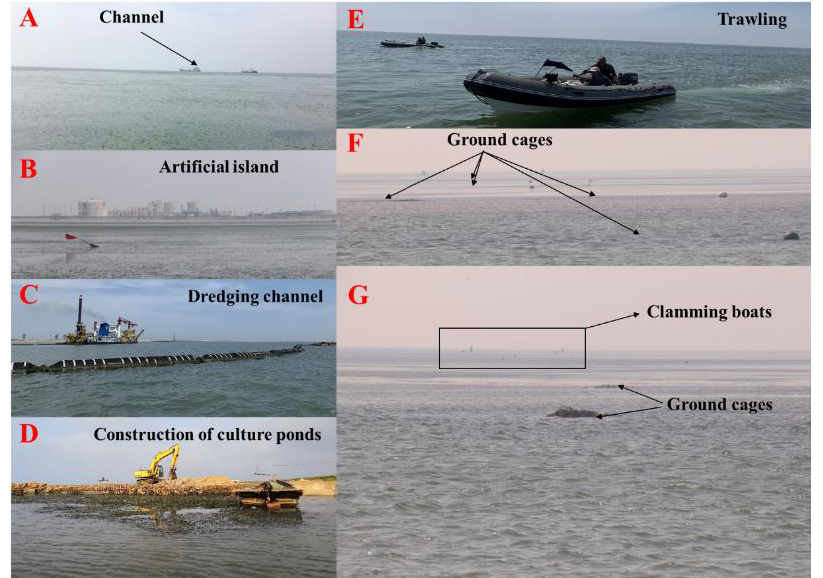
Figure 12. Existing seagrass beds are subjected to threats resulting from artificial factors, especially anthropogenic causes, such as ( A ) boating in channels near seagrass beds, ( B ) construction of artificial islands and industrial activities on the islands, ( C ) dredging of channels, ( D ) construction of culture ponds, ( E ) trawling, ( F ) fish collection using ground cages, and ( G ) harvesting clams using specific boats.